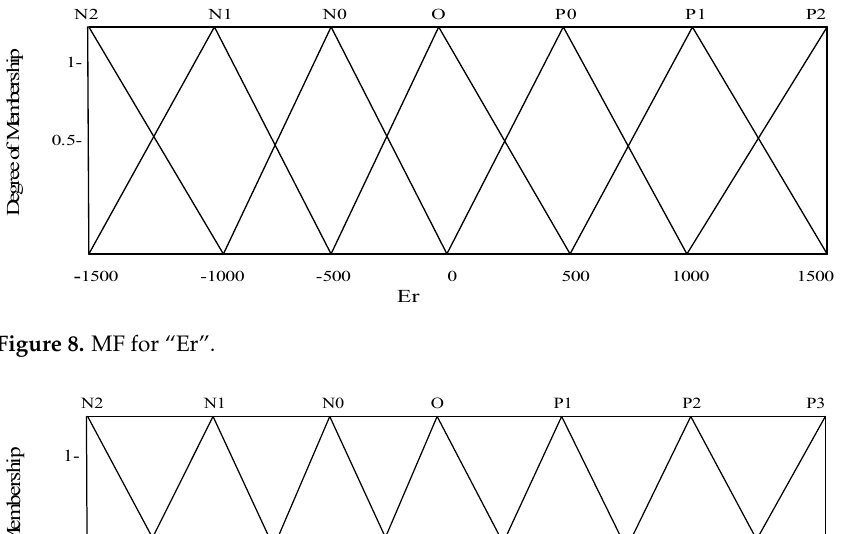
Figure 7. Overview of Fuzzy controller.